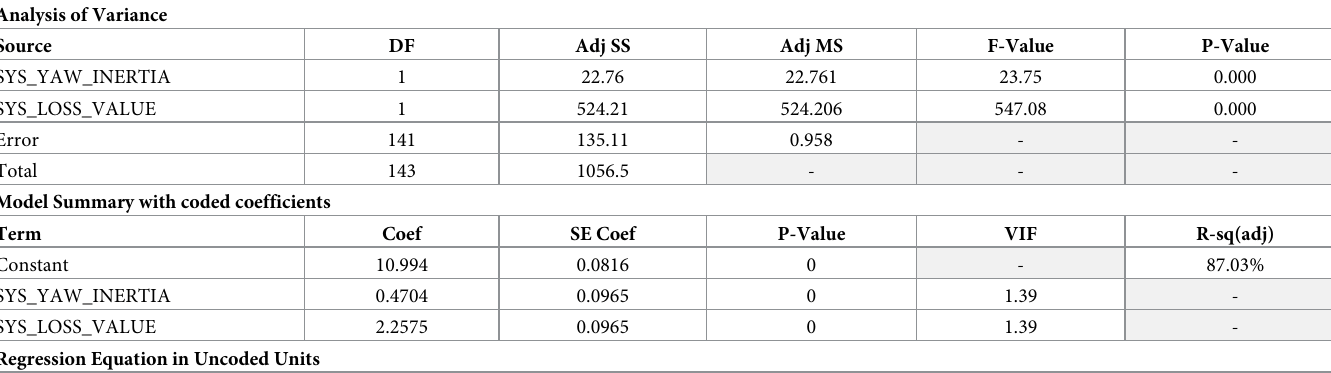
Table 5. Total cost: Zero-radius turns. Analysis of Variance